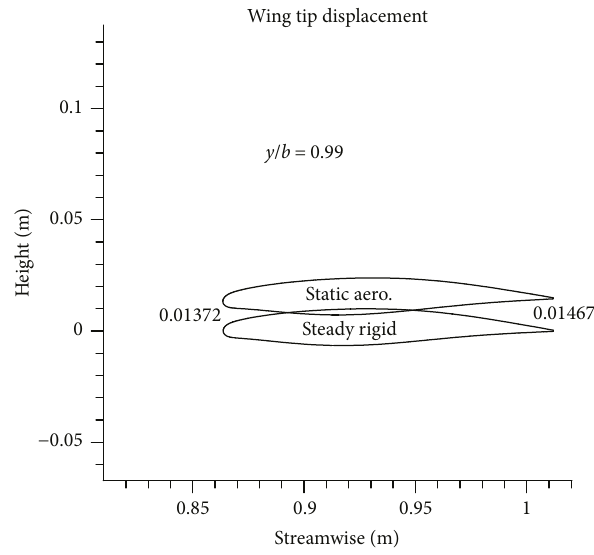
Figure 7: The de fl ection of the wing